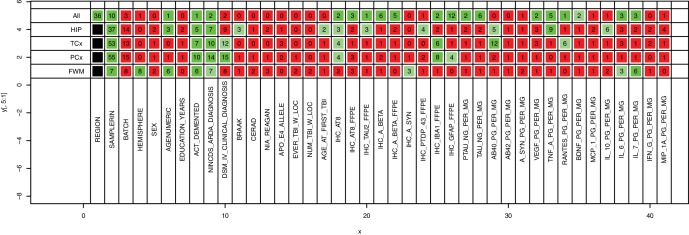
Dominant gene expression signatures in RNA-Seq data are brain region and RIN.MDMR on all uncorrected data (top row) identifies region as the top source of variability, and MDMR run region by region (remaining rows) identifies sample RIN as the top source of variability, highlighting the importance of correcting for RNA quality. Numbers indicate percent of variation explained by a variable (columns) using a univariate model (Materials and methods), and colors indicate significance (green, p<0.01; light green, 0.05 < p < 0.01; red, p>0.05).